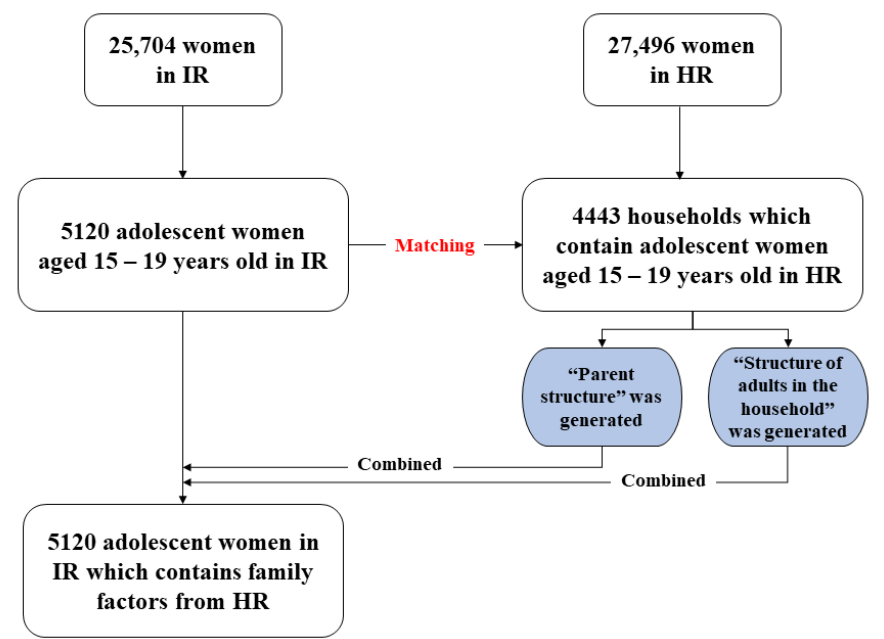
Figure 1. Flowchart combining data from HR to IR.